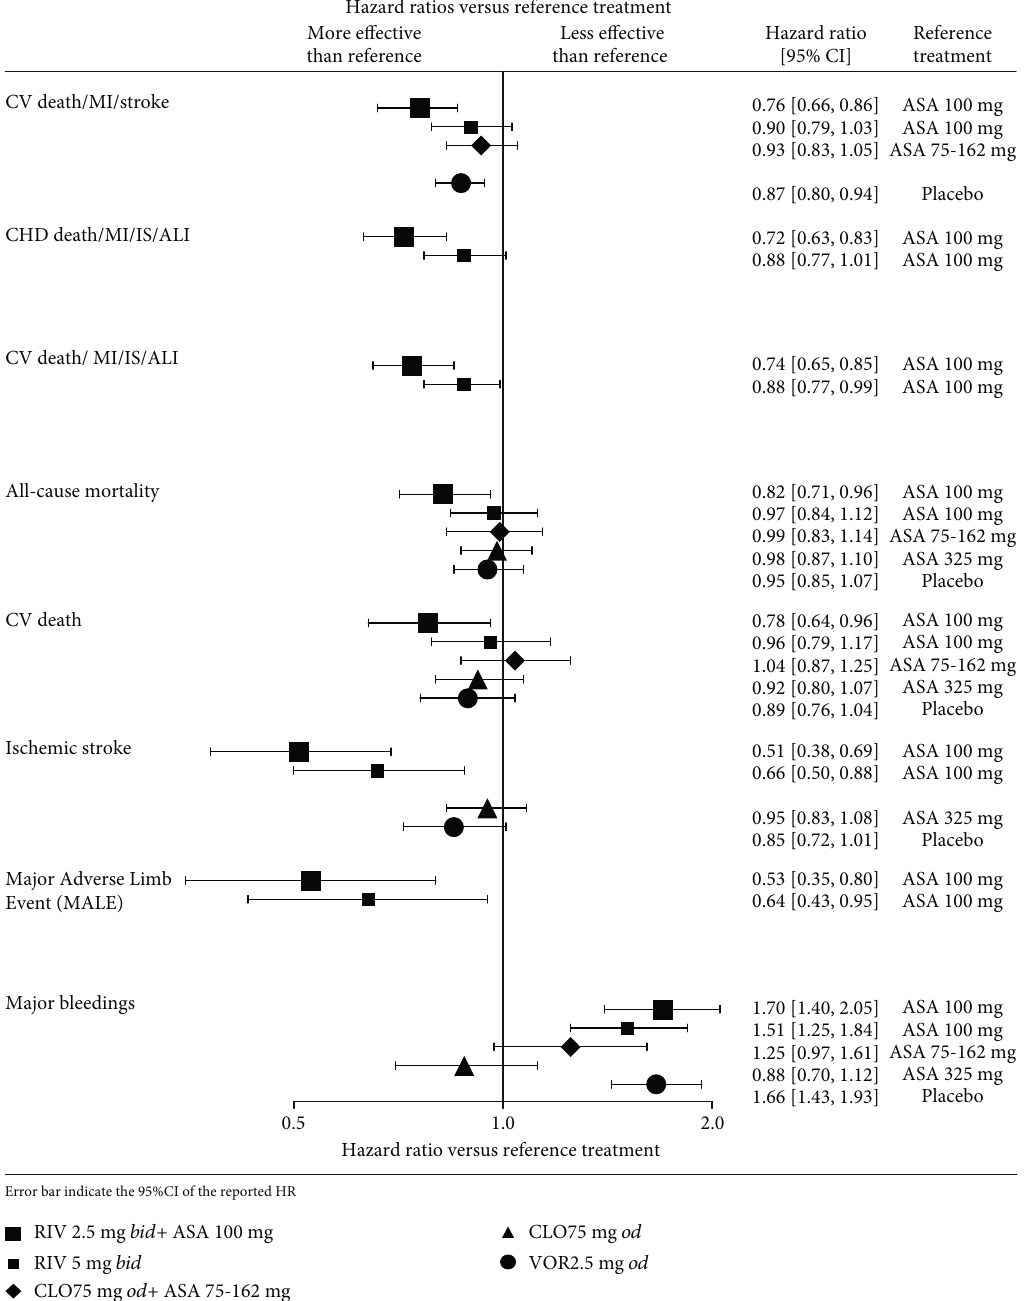
Figure 2: Forest plot with key e ffi cacy and safety results [1, 15, 19, 20]. ASA: acetylsalicylic acid; CLO: clopidogrel; RIV: rivaroxaban; trt: treatment; VOR: